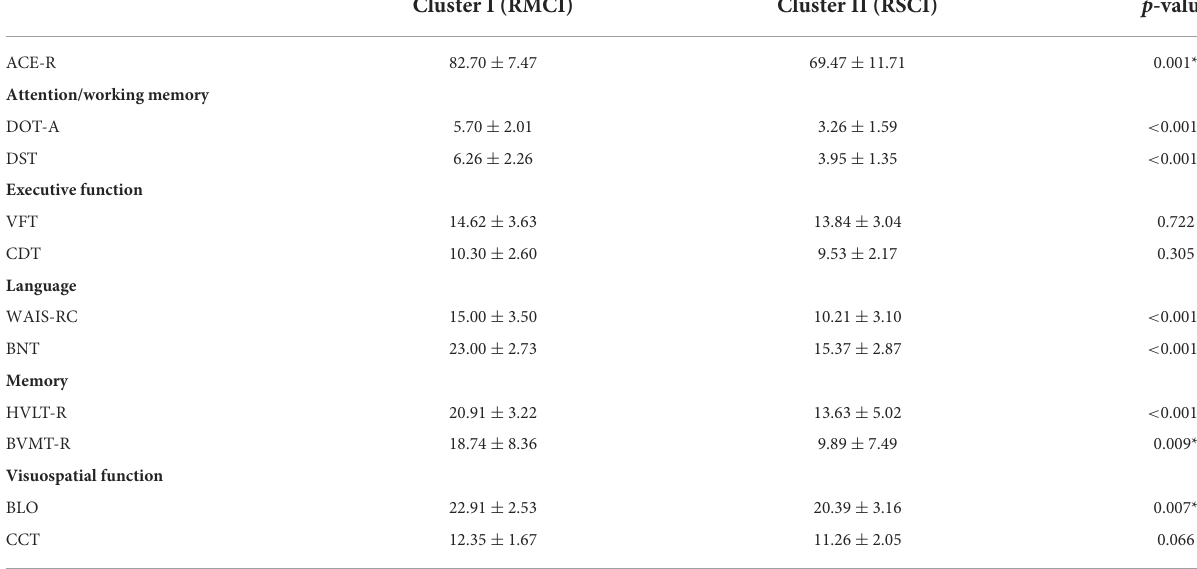
TABLE 7 Cognitive assessments between two